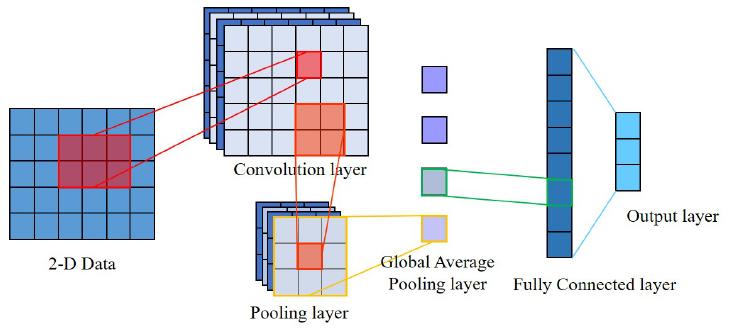
Figure 1. Simple process chart of 2D-CNN for damage region